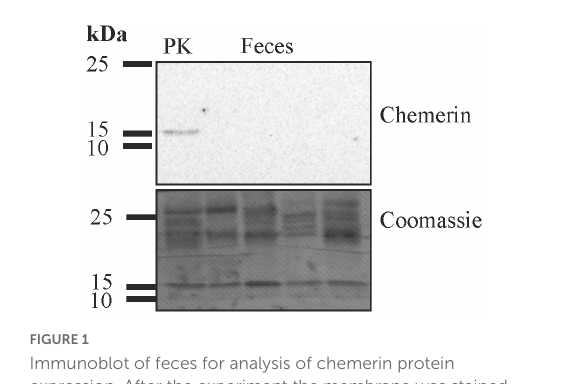
FIGURE1 Immunoblot of feces for analysis of chemerin protein expression. After the experiment the membrane was stained with Coomassie Brilliant Blue R-250. The molecular weight size markers are given. Human liver lysate was used as positive control (PK).